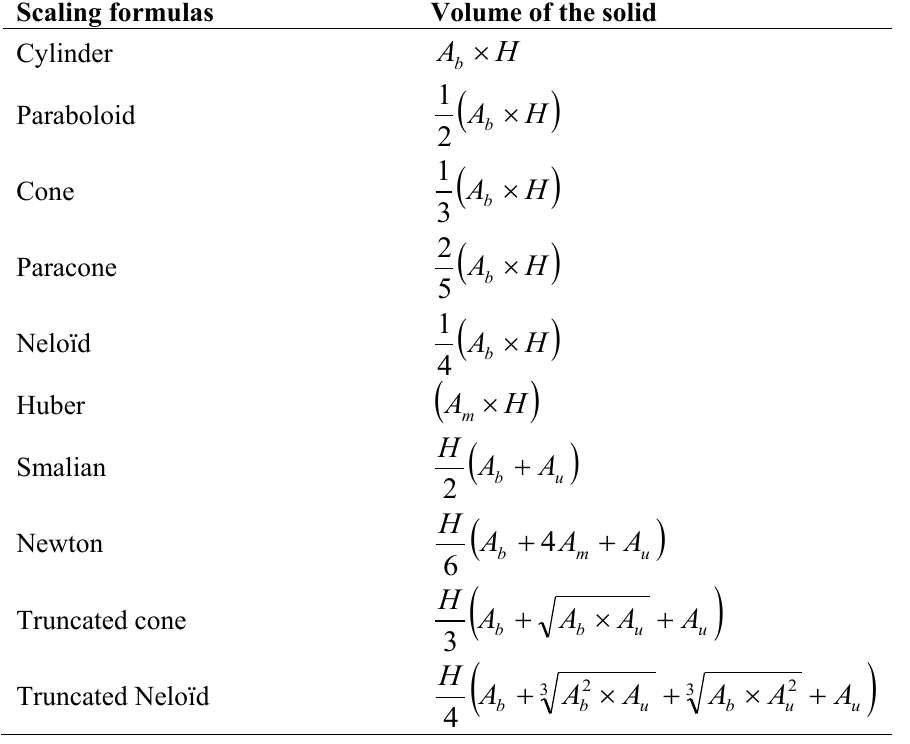
Table 2. Scaling Formulas of dendrometric types and their truncated